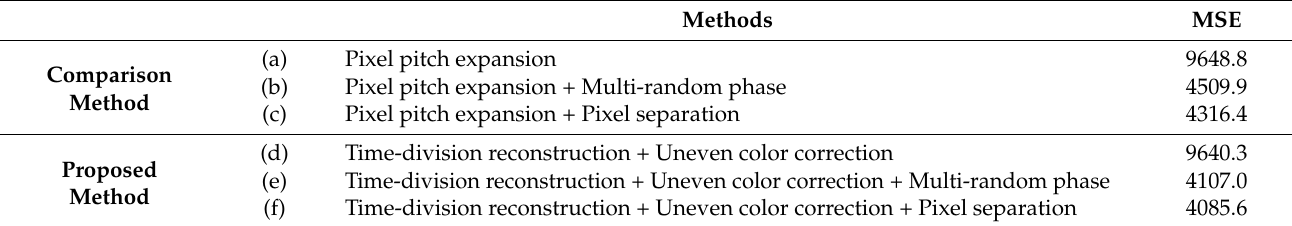
Figure 9. Reconstruction images by simulation: the methods used in ( a – f ) correspond to Table 2. Table 3. Image quality evaluation of simulation results.